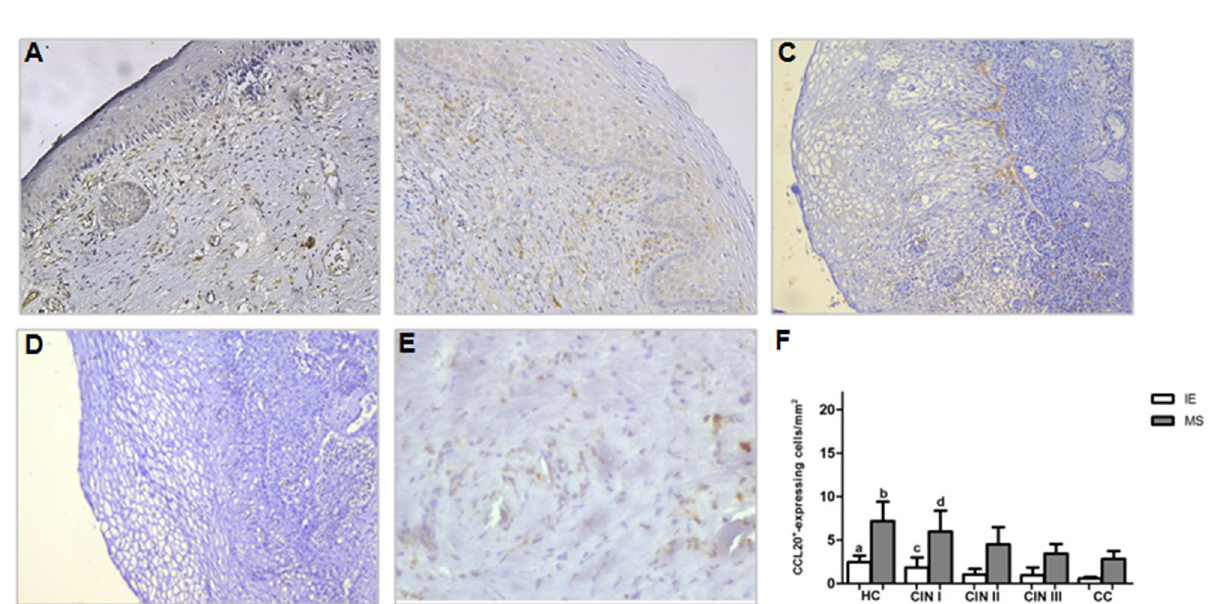
Figure 3. Immunohistochemical staining showing CCL20 + -expressing cells in uterine cervix tissues in IE and MS sites from ( A ) HC, ( B ) CIN I, ( C ) CIN II, ( D ) CIN III, and ( E ) CC. Original magnification = × 20, ( F ) represents the means ± SD of CCL20 expressing cell counts among the groups. a p < 0.01, HC versus CIN II; p < 0.001, HC versus CIN III and CC. b p < 0.05, HC versus CIN II; p < 0.001, HC versus CIN III and CC. c p < 0.05, CIN I versus CIN III and CC. d p < 0.01, CIN I versus CIN III; p < 0.001 CIN I versus CC. P value was calculated using the nonparametric Kruskal–Wallis test and post-test of Dunns for multiple